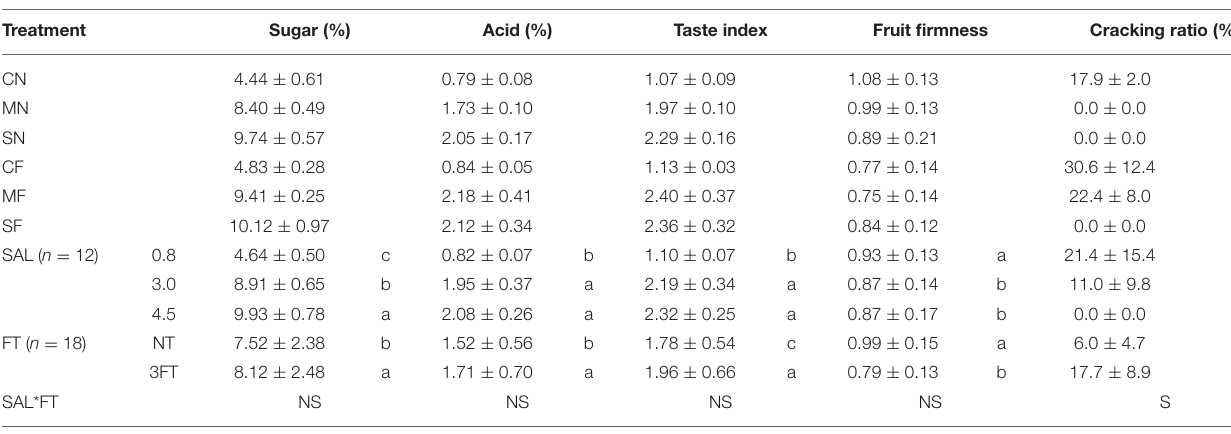
TABLE 5 | Combined treatment on fruit quality. Treatment